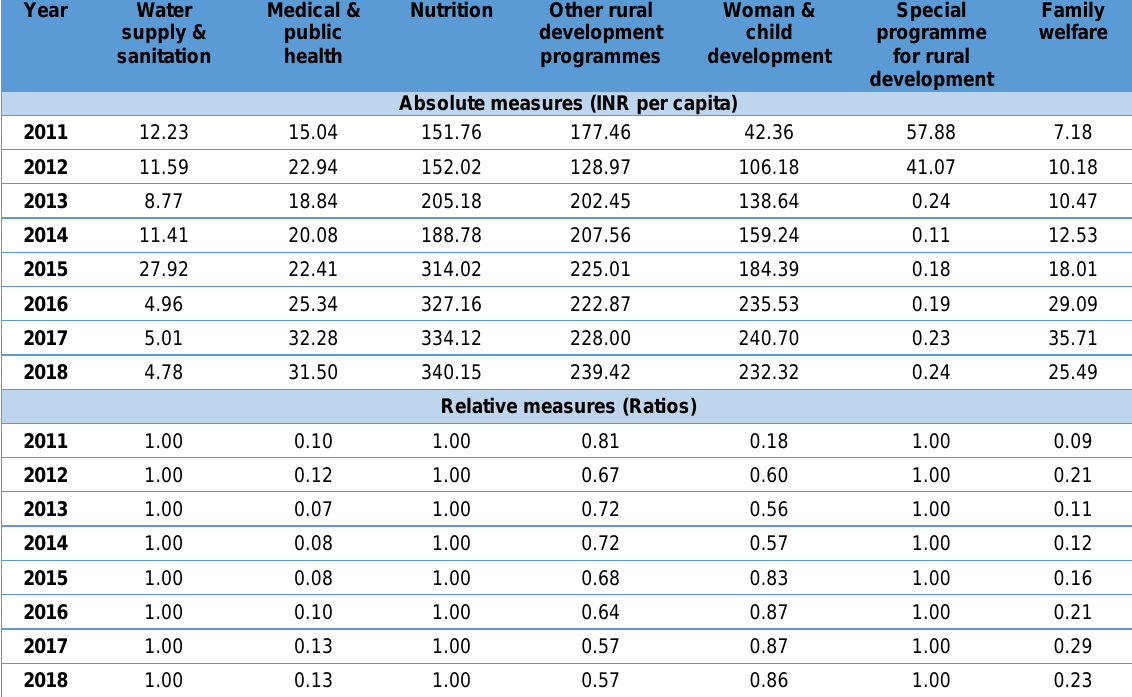
Woman & Special Family child programme welfare development for rural development